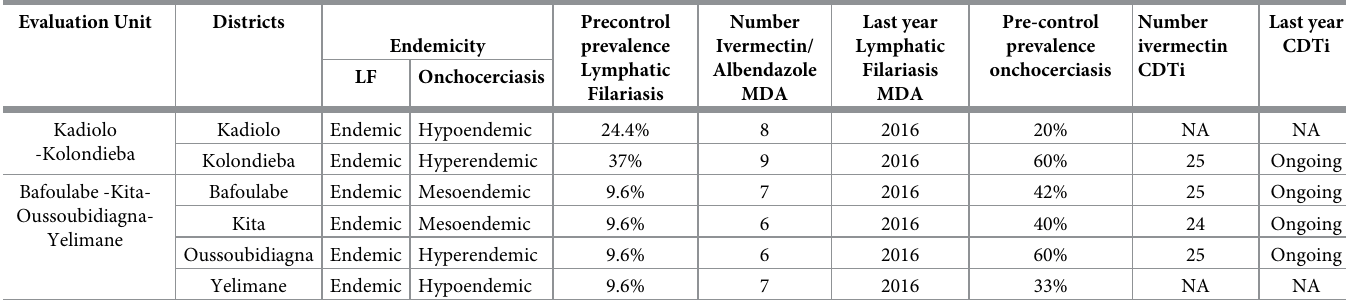
Table 1. Lymphatic filariasis and onchocerciasis pre-control endemicity and current status of mass drug distribution per district. Evaluation